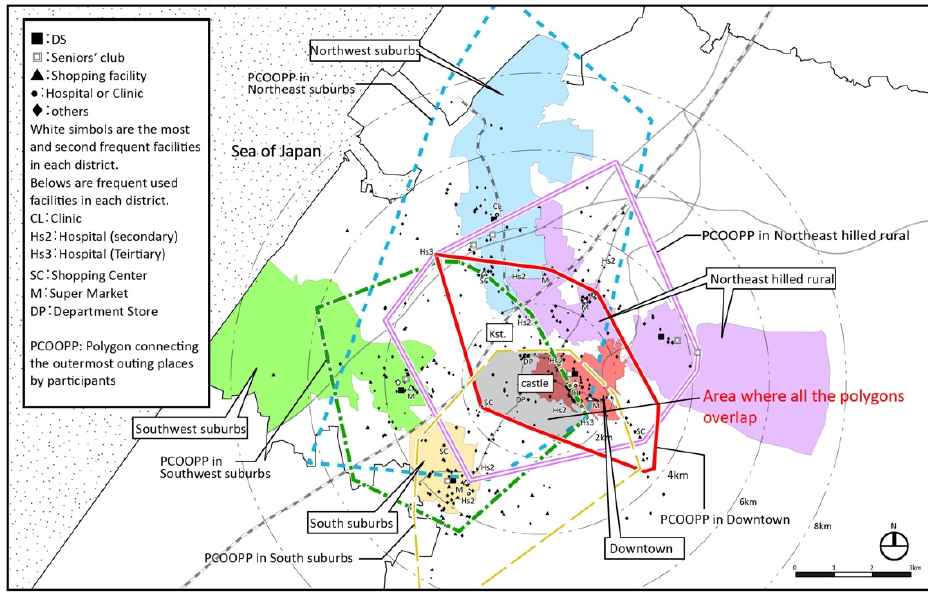
Figure 9. Polygons connecting outermost places visited by participants in each district in Kana- zawa.